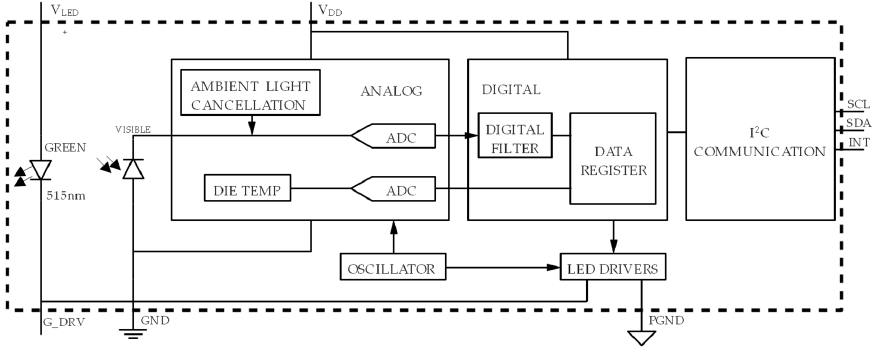
Figure 2. Hardware circuit structure of the heart rate sensor.